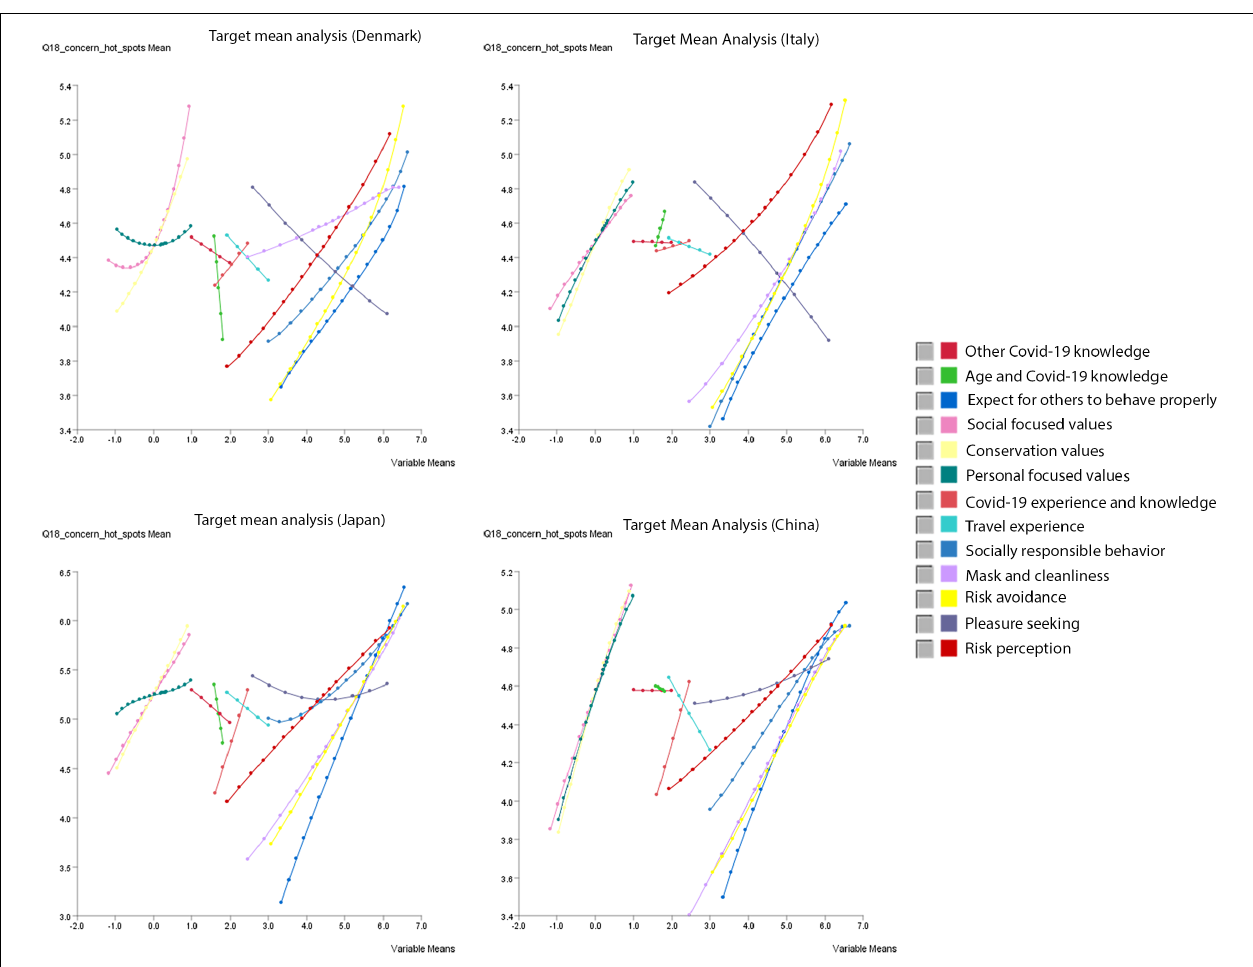
FIGURE 8 | Country-specific target mean analysis: response curves of the target variable (Y-axis) as a function of the values of the 13 factor variables